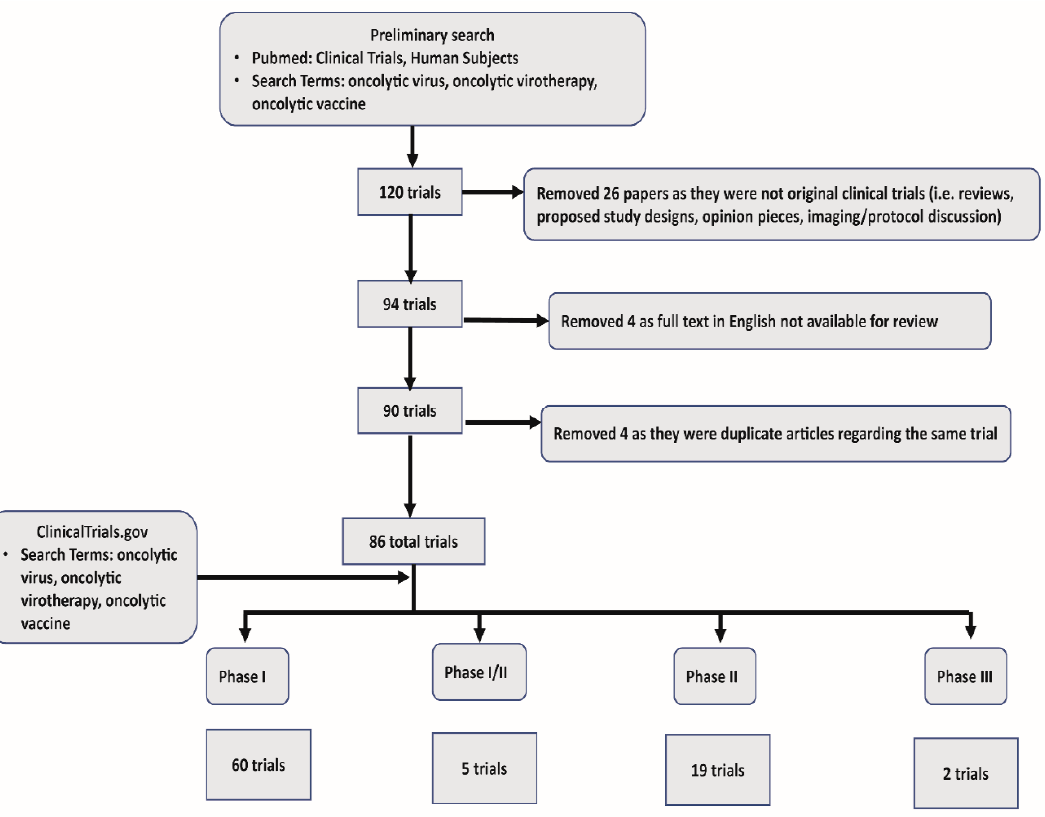
Figure 1. Systematic review schematics.